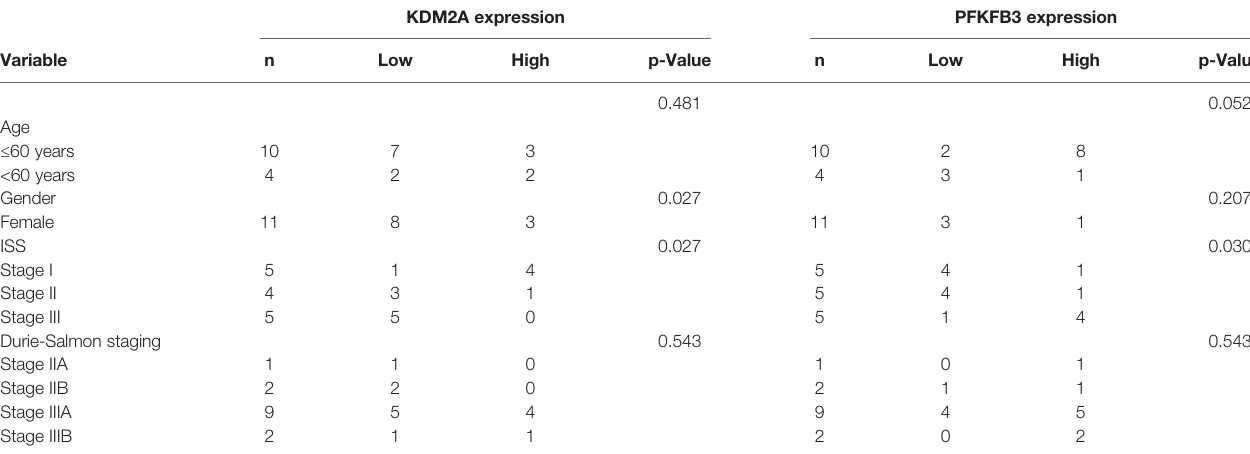
TABLE 1 | Analysis of correlation between KDM2A or PFKFB3 protein levels and clinicopathological parameters of multiple myeloma